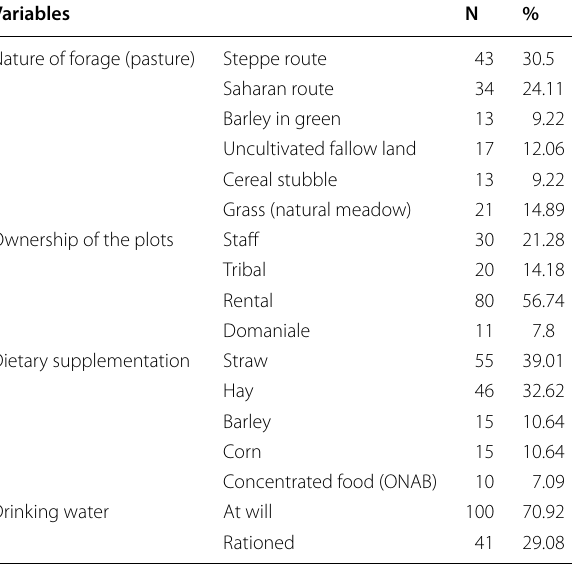
Table 3 Characteristics of the different feeding methods for goats in the different study